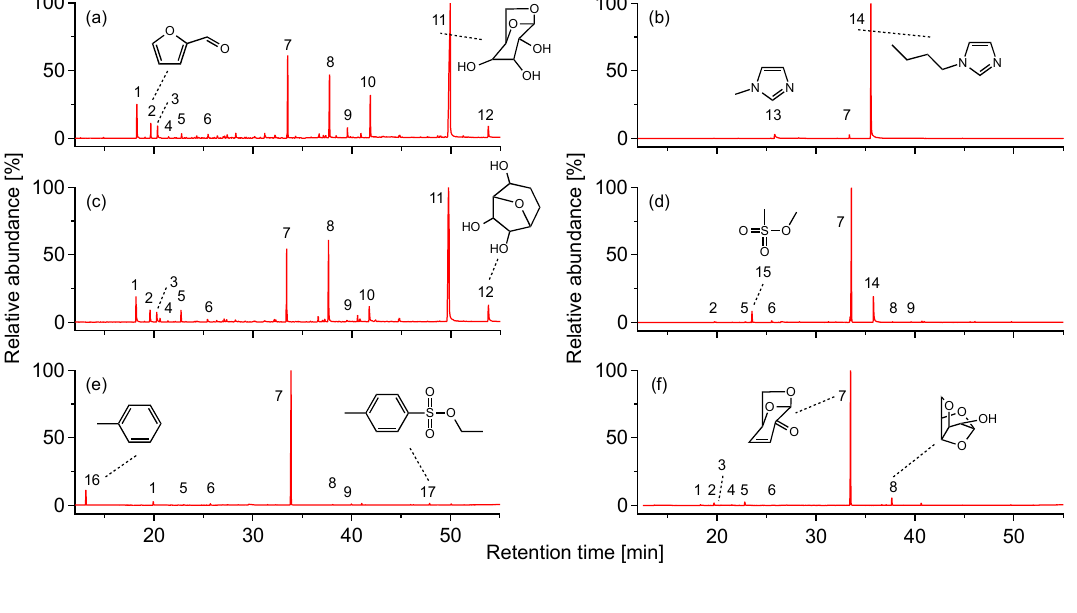
Figure 5. GC-MS chromatograms of condensable matter from pyrolysis of ( a ) cellulose; ( b ) cellulose/[[BMIM]Cl; ( c ) cellulose/[BMMIM](CF SO ; ( e ) cellulose/[EMIM]CH CH 3 3